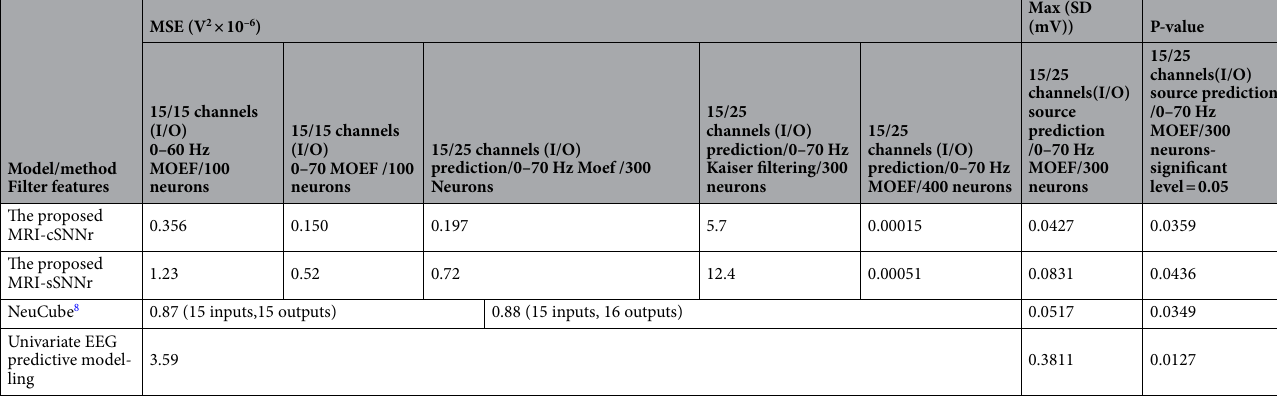
Table 2. MSE,SD and P-Value Test Comparison of Several